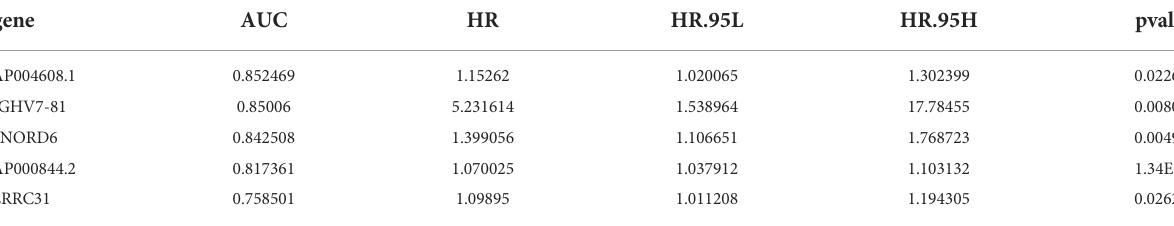
TABLE 2 5 independent prognostic